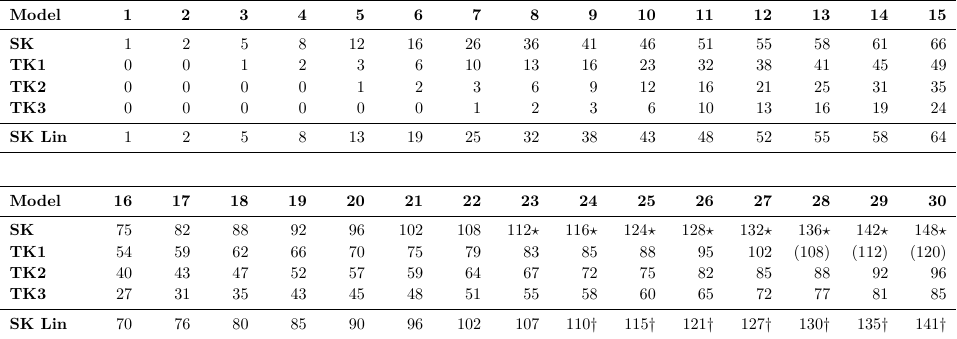
Table 7: The bounds on the number of active Sboxes in SKINNY from [BJK + 16a]. Note that the bounds on the number of linear active Sboxes in the single-key model are also valid in the related-tweakey model. In case the MILP optimization was too long, upper bounds are given between parentheses. The bounds indicated by ? were obtained from [ABI + 18] in which the authors used Matsui’s algorithm for obtaining the minimum number of active Sboxes. The bounds indicated by † were obtained from [NSS20] by using MILP with more informative